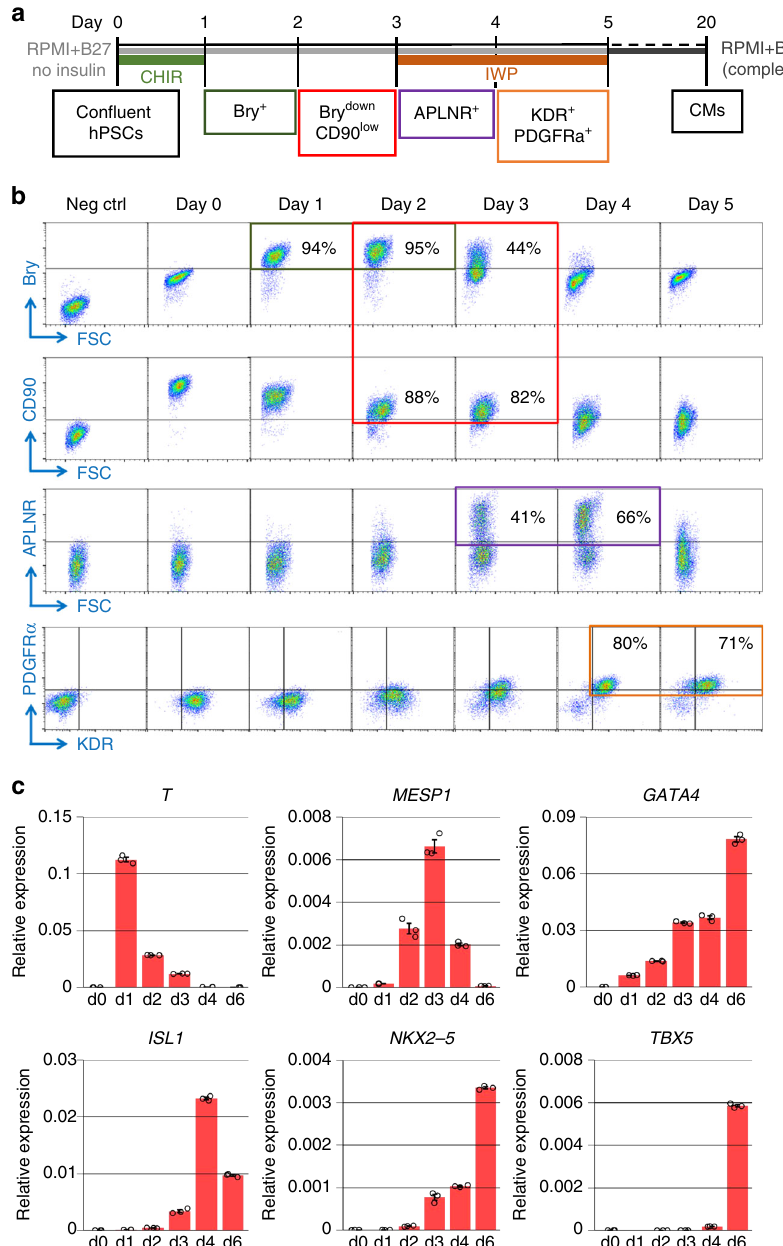
Fig. 1 Identi fi cation of progenitors in cardiac differentiation of hPSCs. a Schematic method for the small molecule protocol using GSK3 β inhibition with CHIR followed by Wnt inhibition with IWP (GiWi protocol) to ef fi ciently differentiate hPSCs to cardiomyocytes (CMs) and the associated markers for